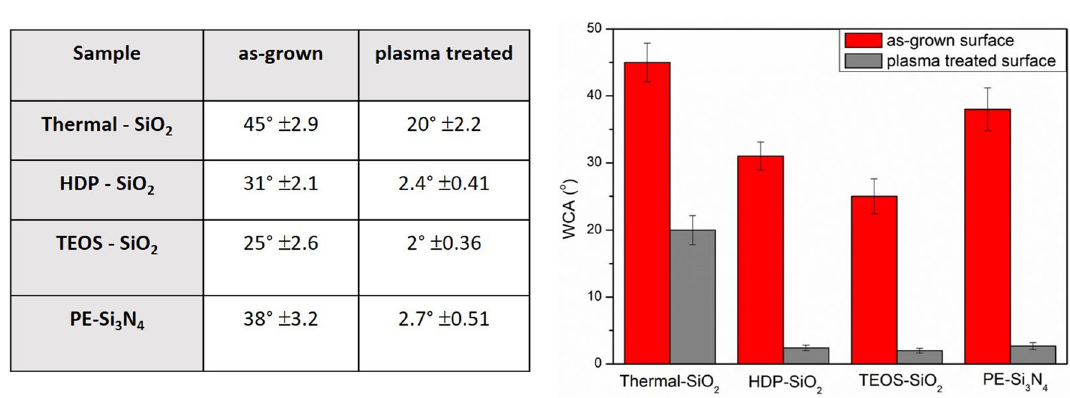
Figure 6. Wetting contact angle values for as-grown and plasma treated SiO 2 and Si 3 N 4